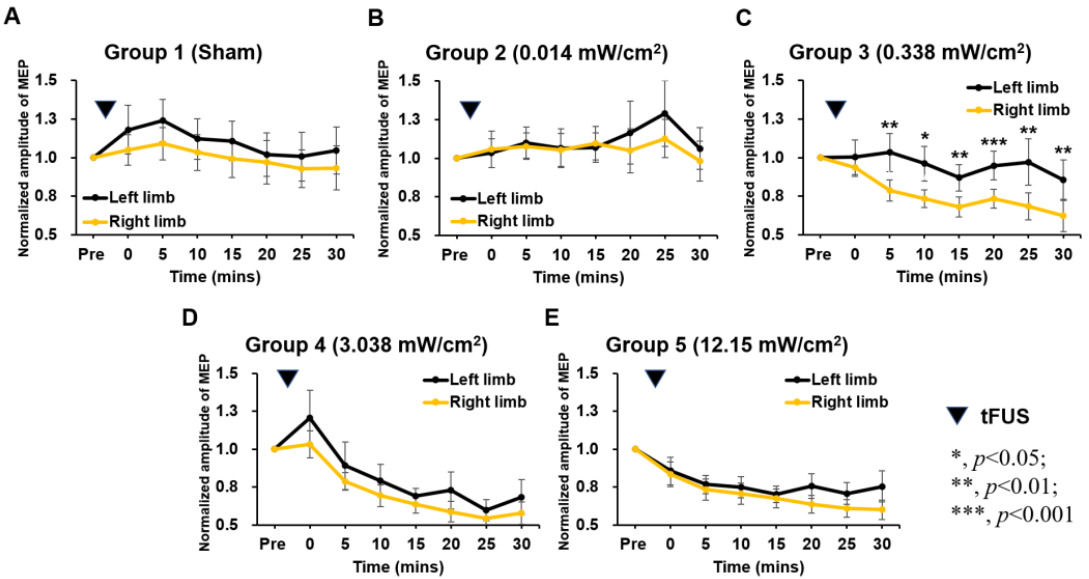
Figure 2. Comparison of the averaged MEP from both limbs in various groups 30 min after tFUS (*, **, and *** represent p values of <0.05, <0.01, and <0.001, respectively).